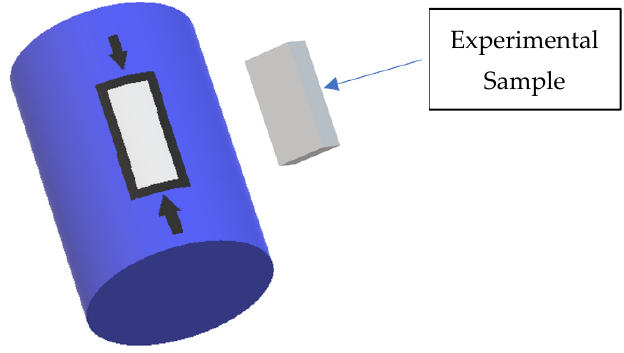
Figure 2. Sampling area for structural analysis.